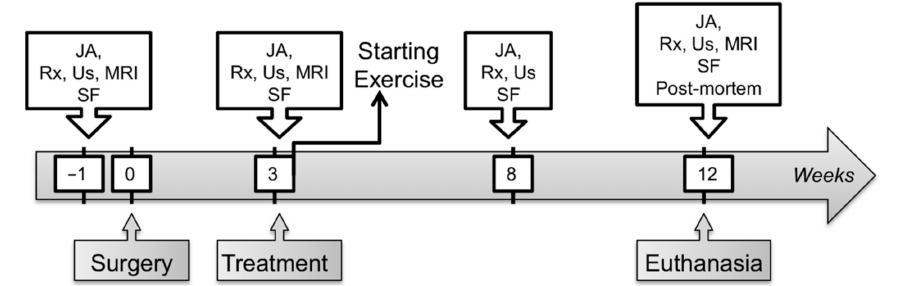
Figure 1. A schematic presentation of the timeline of the study. JA—Joint assessment; Rx— Radiographic examination; Us—Ultrasound examination; MRI—Magnetic resonance imaging; SF— Synovial fluid sampling and analysis; Post-mortem—Post-mortem analysis including macroscopic and microscopic examination of the joints after euthanasia.